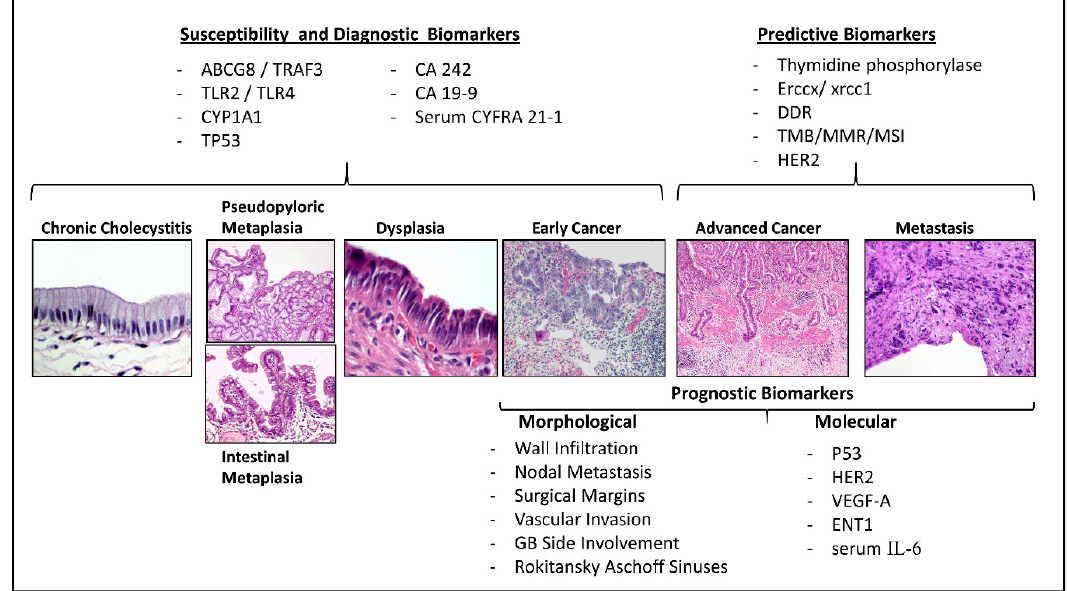
Figure 1. Biomarkers throughout the natural history of gallbladder cancer. Schematic representation of the most significant biomarkers according to the histogenic sequence of gallbladder cancer.